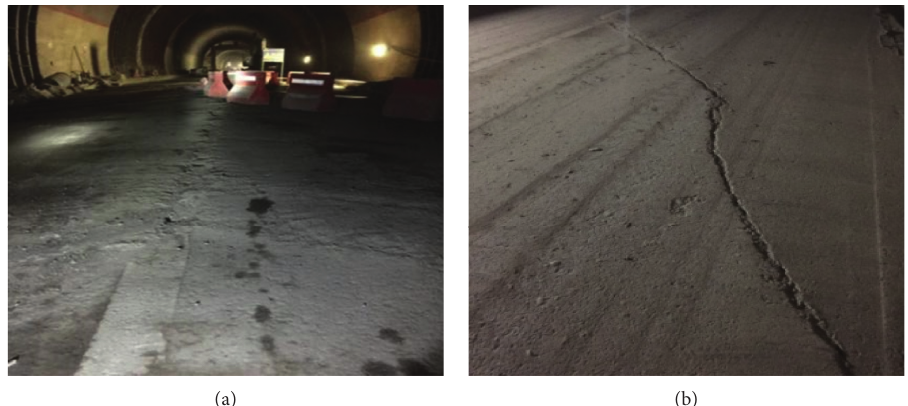
Figure 9: Tunnel diseases in December 2012. (a) Floor heave. (b) Longitudinal cracks on